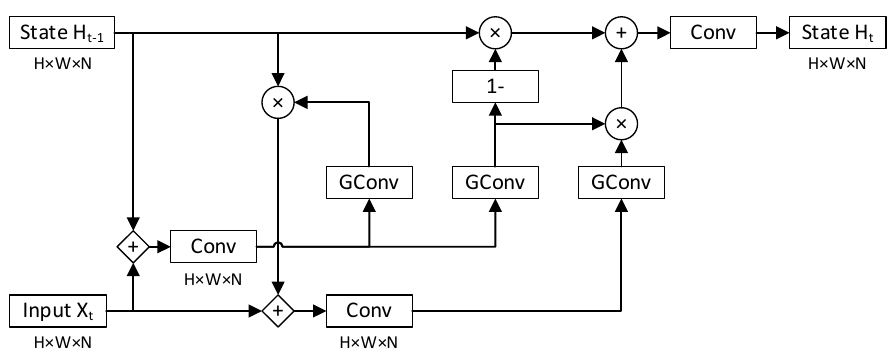
Figure 4. Modified ConvGRU